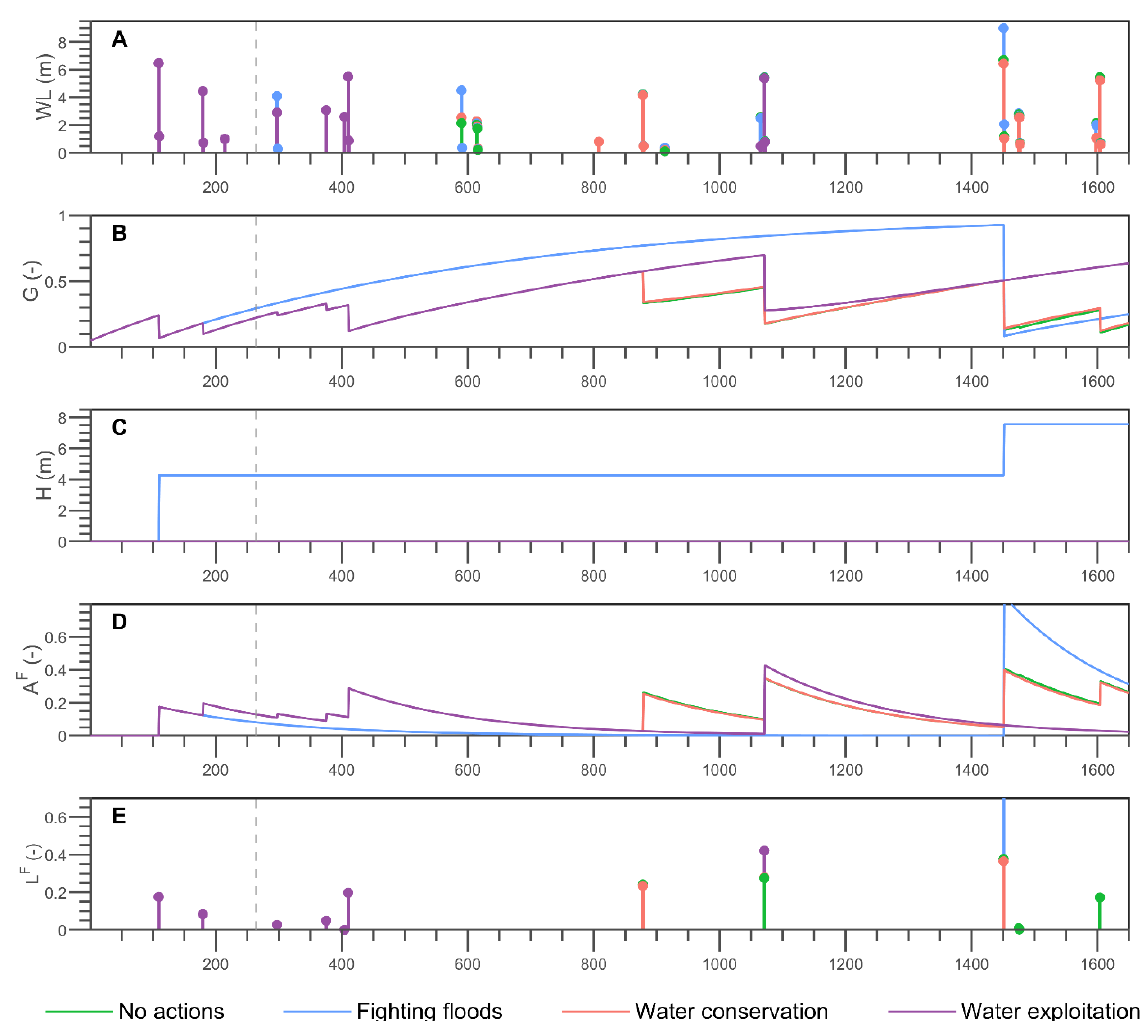
Figure A14. Flooding-based variables of the synthetic experiments additional scenario #3 considering dam construction and human-flood interactions with the four water management strategies introduced in this study. (A) Water level (WL), (B) proportion of population in floodplain (G), (C) levee height (H), (D) flood awareness (AF), and (E) flood losses (LF). The grey dashed line indicates the construction of the Wivenhoe